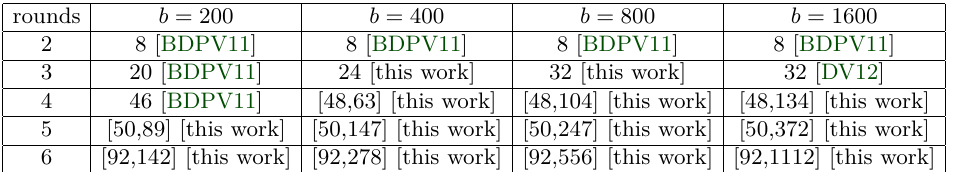
Table 1: Minimum weight or range for the minimum weight of trails for different variants of Keccak - f per instance of Keccak - f [ b ] and number of rounds. A range [ x, y ] means that x is a lower bound and y is the lowest known